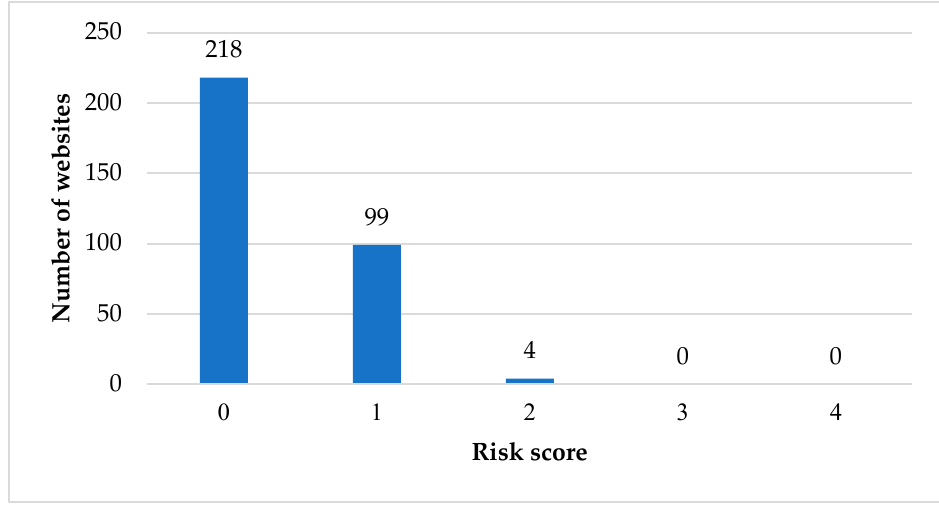
Figure 1. Risk score for the websites evaluated in the study.